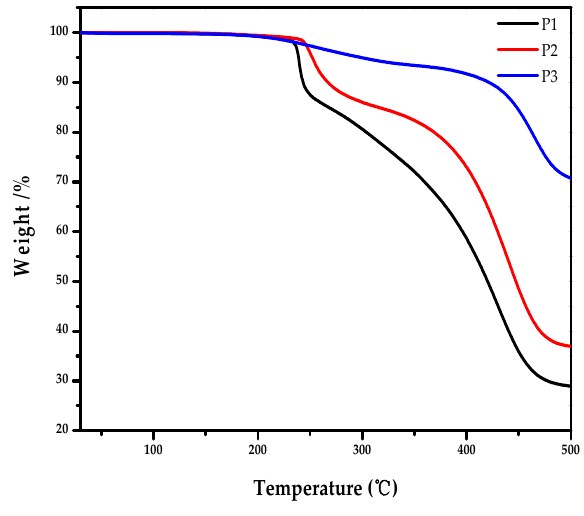
Figure 4. TGA curves for P1, P2 and P3.